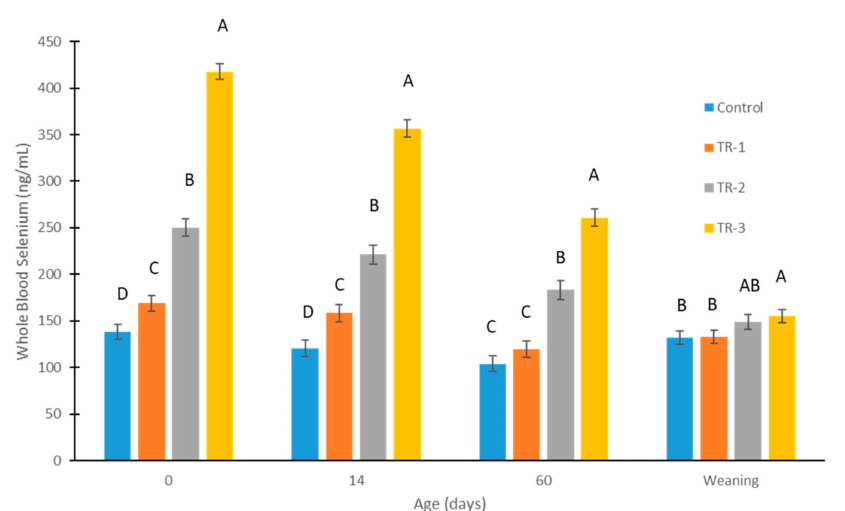
Figure 2. Whole-blood Se concentrations of calves measured at birth, 14 days, 60 days, and at weaning (6.5 to 8 months), from control cows and cows supplemented with Se-yeast boluses (105 mg Se/wk) during the first (TR-1), second (TR-2), and third (TR-3) trimester of gestation. Different letters above bars indicate which groups of calves differed significantly ( p < 0.05) at that timepoint. The p -values for time, treatment groups, and their interaction were all